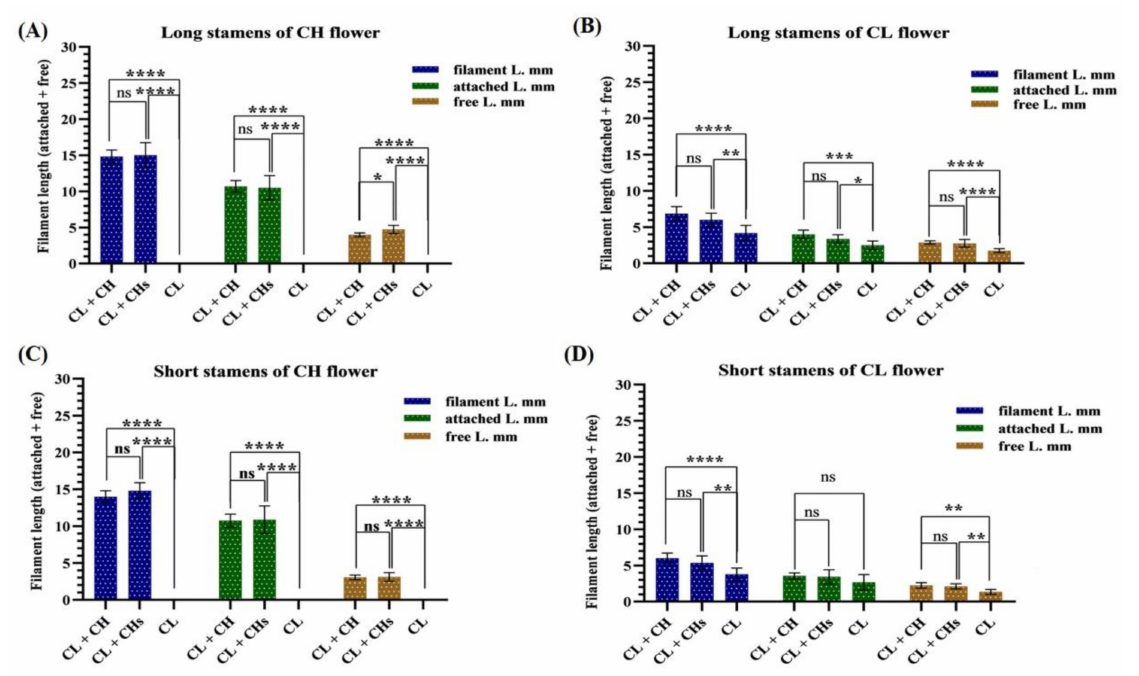
Figure 5. Stamens features in the three morphs ( A – D ) Diversity in stamens filament (short and long).